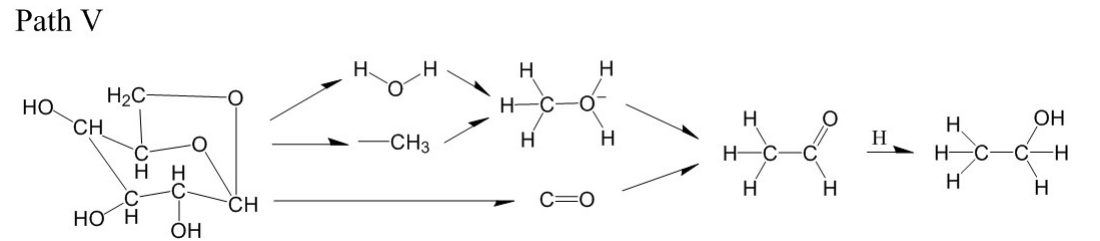
Figure 20. Relevant path V of ethanol generation at 2800 K.